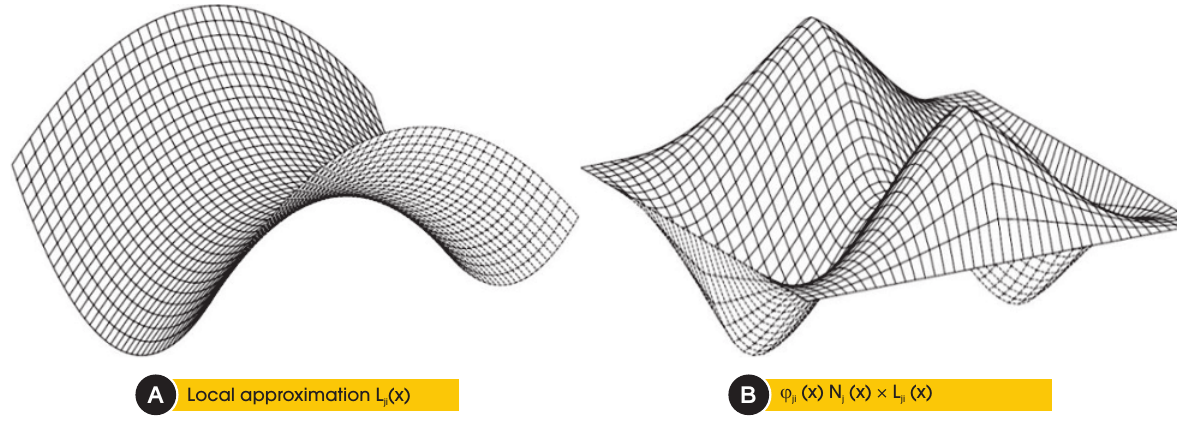
Strategy of enrichment of the cloud ω